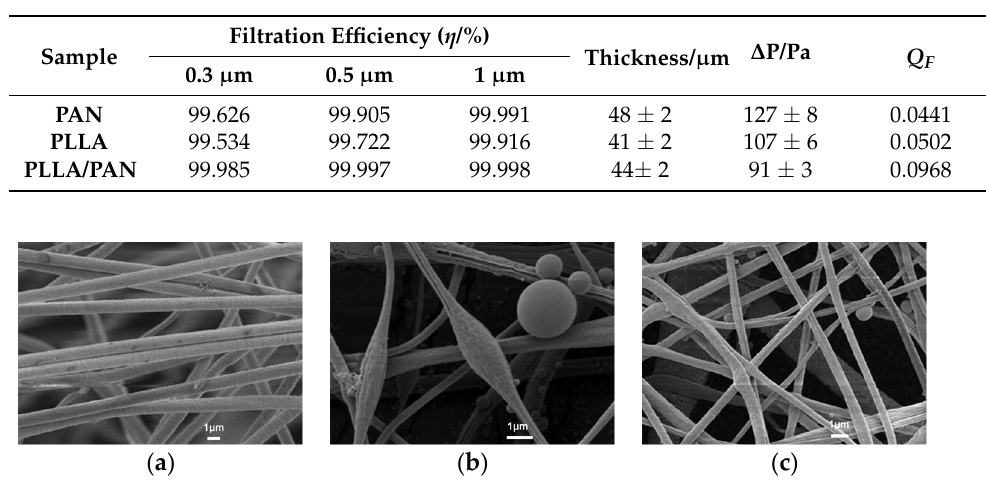
Figure 6. SEM images of samples after filter test with NaCl aerosol, ( a ) PLLA fiber, ( b ) PAN fiber, ( c ) PLLA/PAN composite fiber. ( c ) PLLA/PAN composite